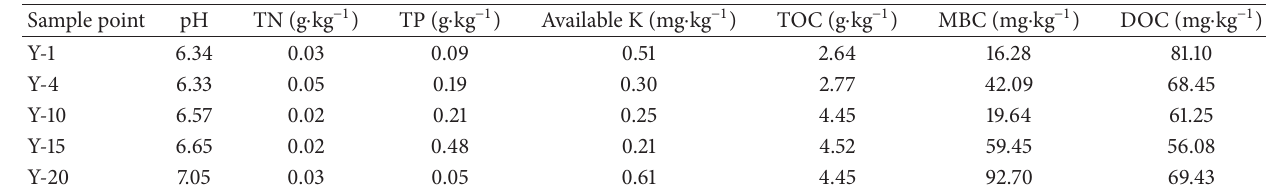
Table 3: Basic chemical properties of the soil samples.